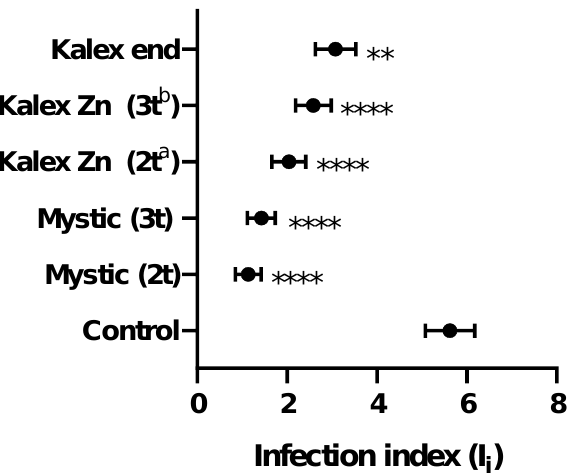
Figure 3. Infection index (Ii) based on qPCR-specific detection of Gnomoniopsis castaneae from chestnut fruits of trees in the six treatments in 2020. Bars represent the SEM. Statistical differences with the untreated control at the Dunn multiple comparison tests are evidenced by ** = p < 0.01, and **** = p < 0.0001. a two treatments (June and July), b three treatment (June, July and August).